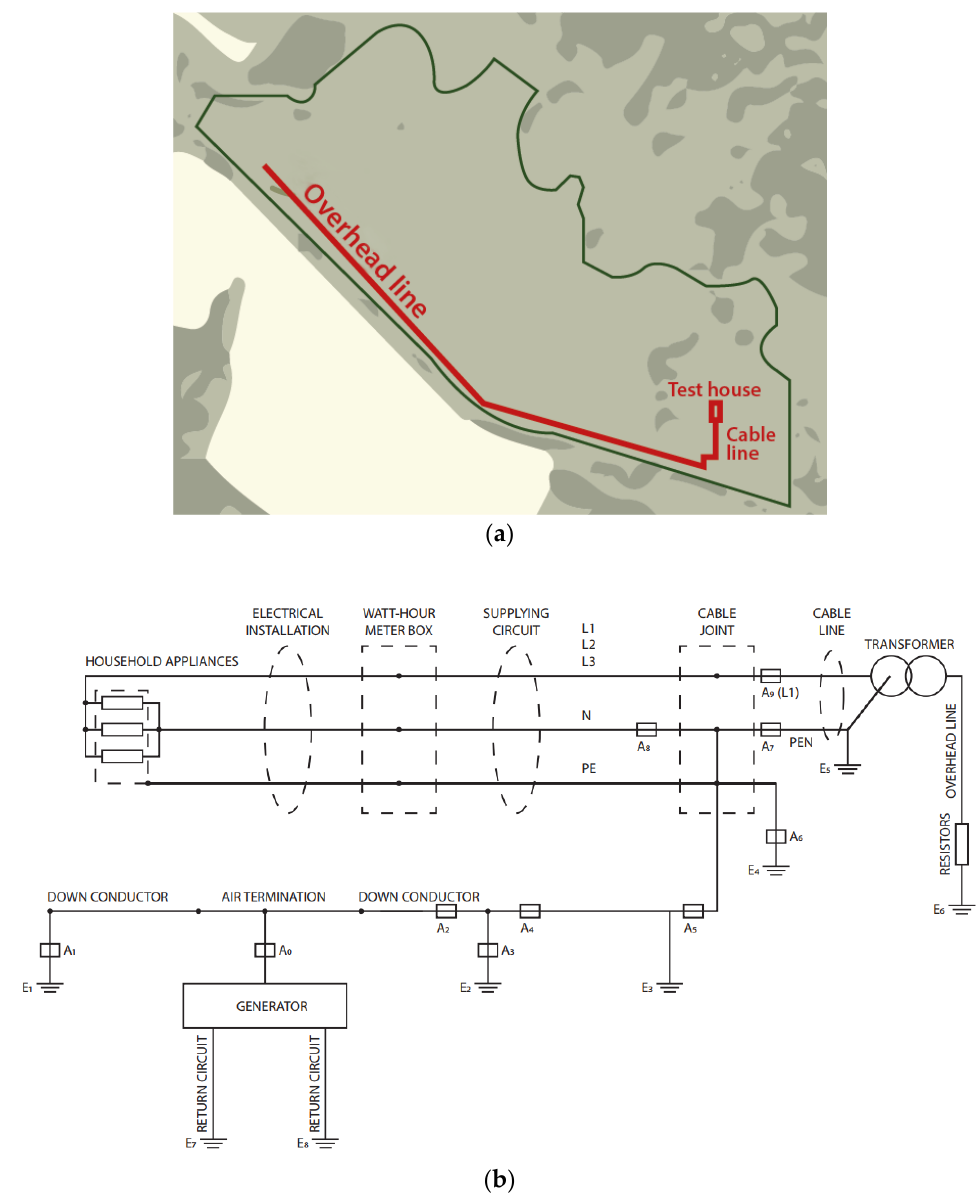
Figure 1. The general view of the open-air test site, where a mobile impulse current generator was used. ( a ) Satellite map, with the main elements of the test system drawn on this map. ( b ) Schematic diagram with labeled system components, such as groundings (E 1 to E 8 ) and measuring points (A 0 to A 9 ).